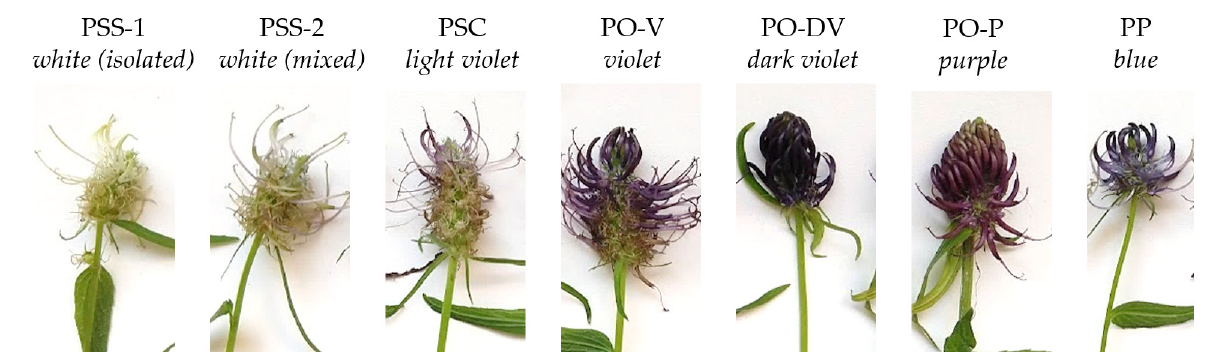
Figure 1. Color variation in Phyteuma species from Pohorje, Slovenia. PSS-1: P. spicatum ssp. spicatum populations growing alone; PSS-2: P. spicatum ssp. spicatum growing in sympatry with P. spicatum ssp. caeruleum ; PSC: P. spicatum ssp. caeruleum ; PO-V: P. ovatum populations with violet flowers; PO-DV: P. ovatum populations with dark violet flowers; PO-P: P. ovatum populations with purple flowers; PP: P. persicifolium .